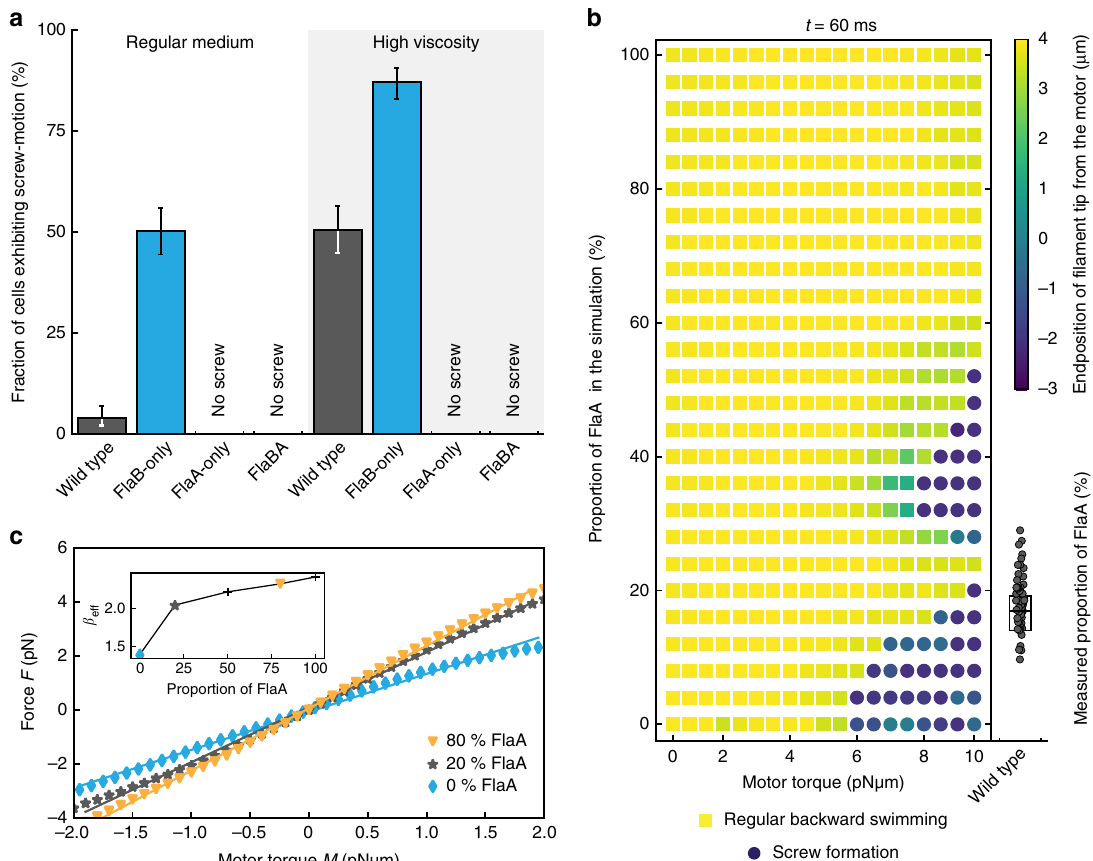
Fig. 4 Experimentally observed and simulated screw formation. a The probability of screw formation of wild-type (FlaAB) and FlaB-only cells increases in high viscosity, while for FlaA-only and FlaBA screw formation was never observed. Signi fi cance was tested for all fi lament combinations under both conditions and for each fi lament between the two conditions. If no screw was observed at all, signi fi cance was not tested. All tested combinations were signi fi cant ( P < 0.05, Bonferroni corrected). Error bars indicate 95% con fi dence intervals. About 300 cells were counted for each strain. b Observation of screw formation for varying fl agellin compositions at different motor torques after a simulation time of t = 60 ms. The simulation was carried out for fl agella with an increasing number of FlaA segments, starting with a fl agellum completely composed of FlaB (bottom of the diagram) and successively exchanging the segments to a FlaA con fi guration starting from the fi lament ’ s base. Yellow squares indicate regular backward rotation, blue dots indicate screw formation. The color coding represents the z-position of the fl agellum ’ s free end, with negative values indicating a position below the motor segment (position 0). For comparison with the actual fl agellin composition in the wild type experimentally measured FlaA proportions are given on the right. Data points are displayed as individual values (gray dots) measured for 50 fi laments. The box spans the central half of the data, the black bar indicates the median. A movie of the simulation with FlaA-only and FlaB-only fi laments is provided as Supplementary Movie 2. c Force-torque relation extracted from the numerical simulation. The mean force F on the fl agellum varies linearly with motor torque M for both forward and backward swimming. Shown are the relations for a FlaB-only fl agellum (blue diamonds), a 20% admixture of FlaA (gray stars) and an 80% admixture (orange triangles). The continuous lines are linear fi ts to the data. The slope β eff in F = β eff M versus the FlaA content is shown in the inset: it increases rapidly up to about 20% FlaA and more slowly for larger fractions. A higher value of β eff indicates a more ef fi cient transfer of torque into driving